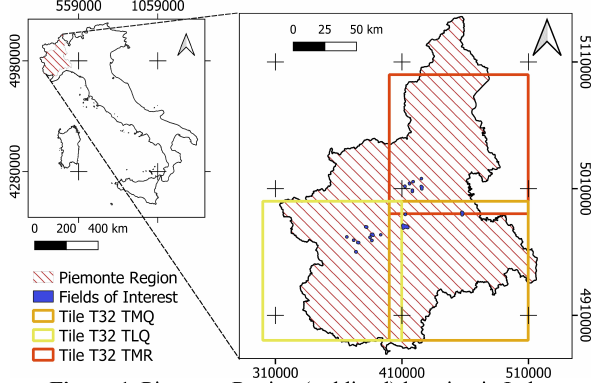
Figure 1. Piemonte Region (red lined) location in Italy. Reference fields are represented by blue polygons. Orange/yellow/red squares border S2 tiles (Reference System: WGS84/UTM 32 N).